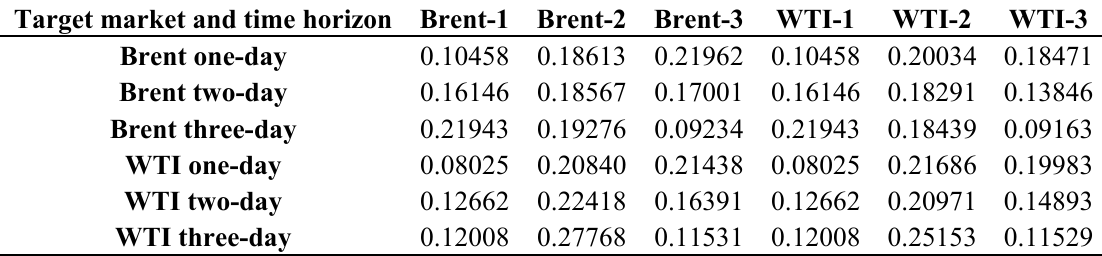
Table 9. Average Coefficients of MKR for one-day, two-day, and three-day ahead predictions (14 experiments for each time